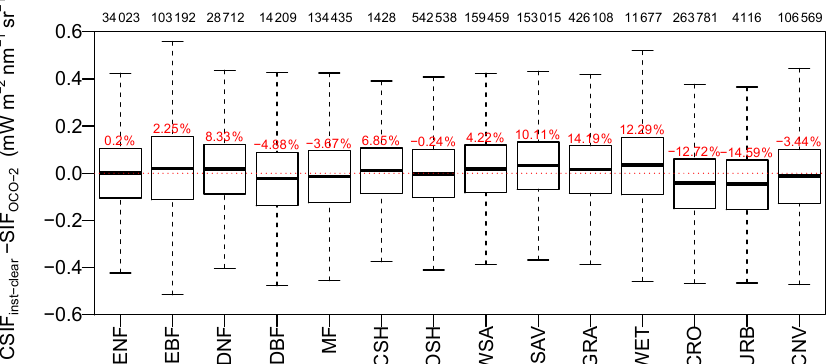
Figure 3. Difference between CSIF clear-inst and SIF OCO-2 for major biome types during 2014–2017. The MODIS land cover dataset for 2010 was used to identify the land cover type for each 0.05 ◦ grid cell (Friedl et al., 2010). The red percentages above each box represent the mean relative error, and the numbers on top of the figure frame represent the total sample numbers for each biome type. Abbreviations are as follows: ENF, evergreen needleleaf forest; EBF, evergreen broadleaf forest; DNF, deciduous needleleaf forest; DBF, deciduous broadleaf forest; MF, mixed forest; CSH, closed shrubland; OSH, open shrubland; WSA, woody savannas; SAV, savannas; GRA, grassland;